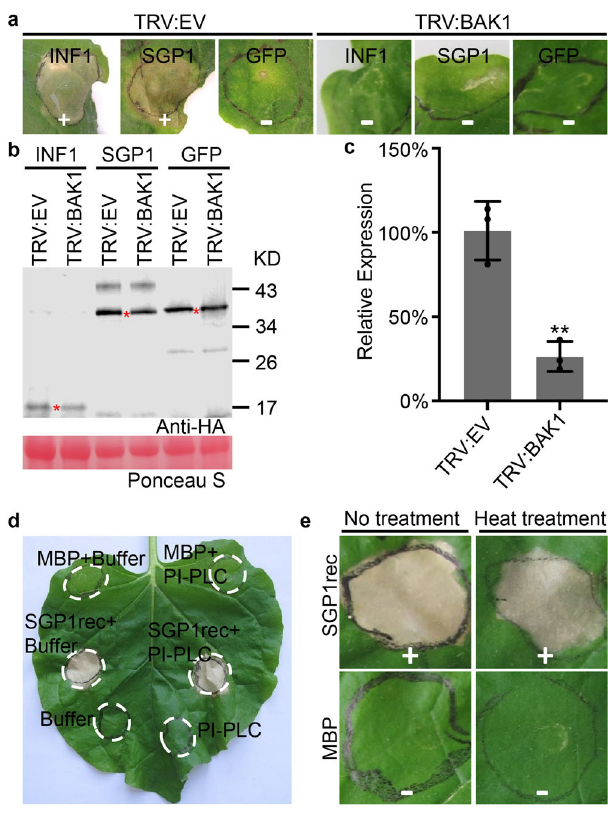
Fig. 3 Cell death triggered by SGP1 requires BAK1 but is not affected after treatment with PI-PLC or heat in N. benthamiana . a – c Cell death triggered by SGP1 requires BAK1. a SGP1-triggered cell death in TRV-silenced N. benthamiana . Representative photographs were taken at 5 days post- in fi ltration. Data were obtained from 3 independent experiments, each of which used 10 VIGS-silenced plants per line (Supplementary Data 3). The plus symbol ( + ) indicates a positive cell death phenotype; minus symbol ( − ) indicates the absence of a clear cell death phenotype. b Western blot analysis of proteins transiently expressed in VIGS-silenced N. benthamiana leaves. The red asterisks (*) indicate the predicted protein sizes. c qRT-PCR quanti fi cation of relative transcript levels of BAK1 in VIGS-silenced N. benthamiana leaves, normalized to those in TRV: EV lines, using the EF1 α gene as an internal reference. Means and standard deviations obtained from three biological replicates. (** P < 0.01, two-sided t -test). d Cell death control. Data represent the results of three independent experiments in each of which one leaf was sampled and in fi ltrated from each of three plants per treatment (Supplementary Data 3). e Cell death response